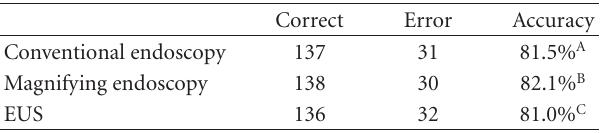
Table 2: Comparison of diagnostic accuracy among 3 di ff er- ent endoscopic techniques (conventional endoscopy, magnifying endoscopy, and EUS).